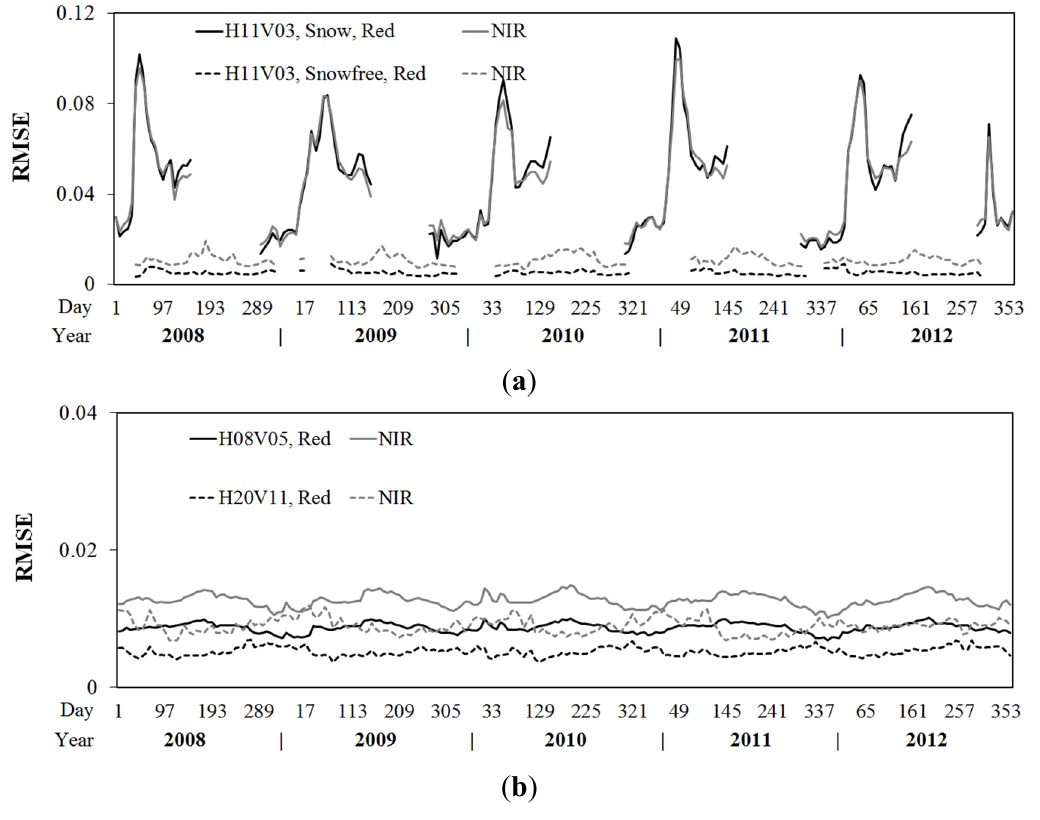
Figure 4. The average fit-RMSEs of ( a ) tile H11V03 and ( b ) tile H08V05, H20V11 calculated from BRDF archetypes from 2008 to 2012 in the red (black lines) and NIR (grey lines) bands. The solid lines in (a) refer to the results of the snow-covered surface from tile